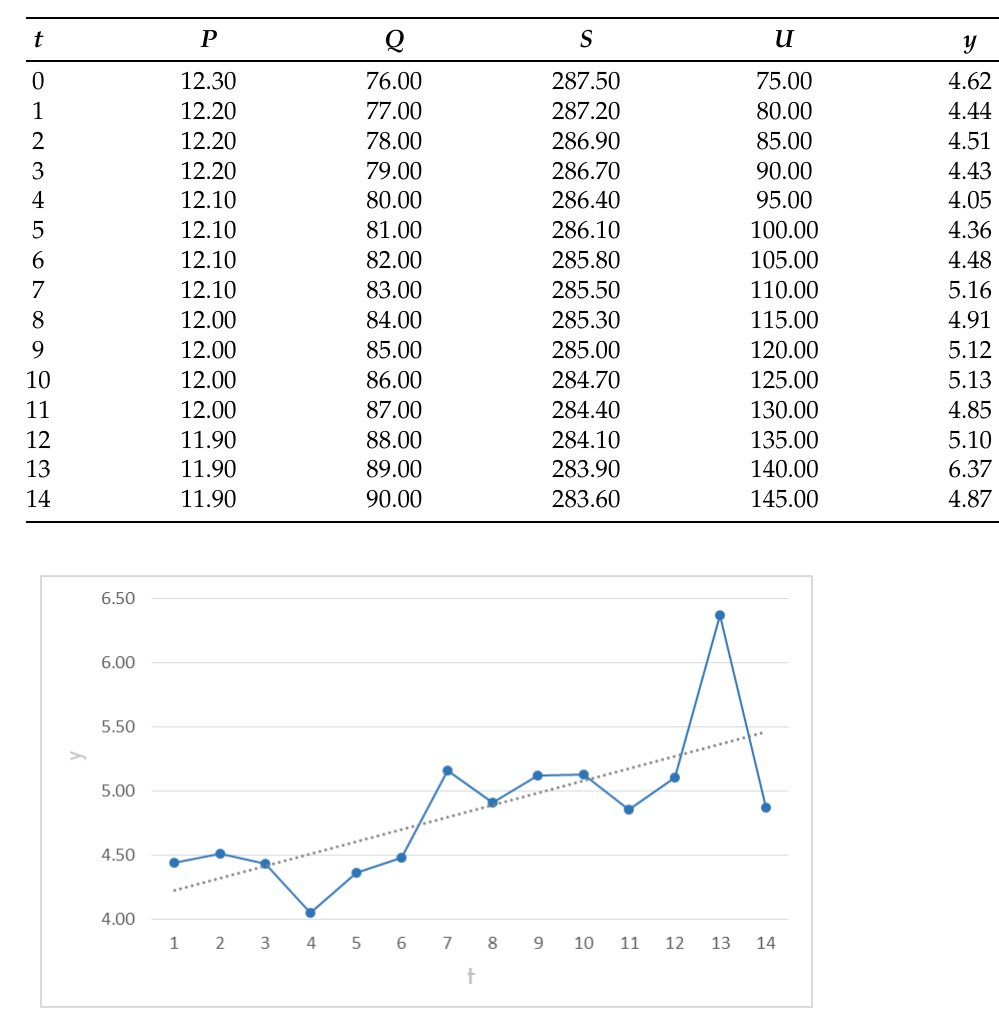
Table 1. Implementation of steepest ascent path for Case 1.